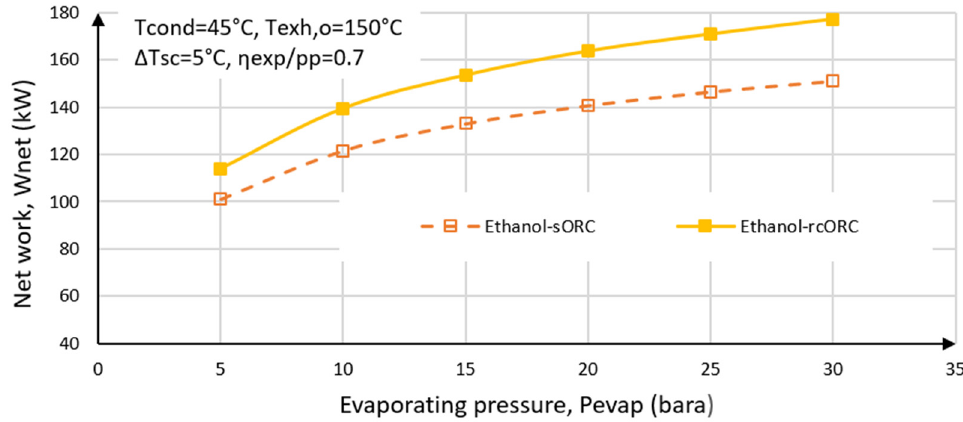
Figure 14. Net work against evaporating pressure (Ethanol sORC versus rcORC).